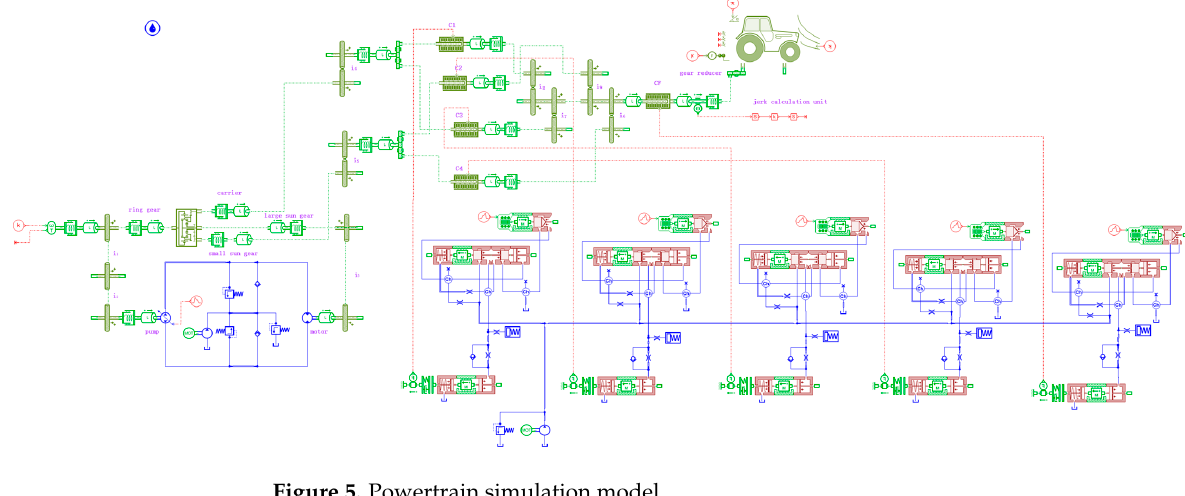
Figure 5. Powertrain simulation model.